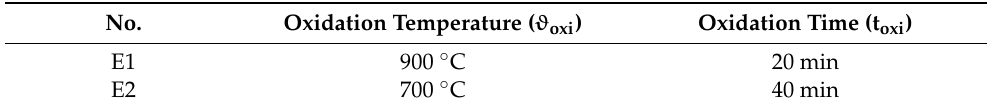
Table 1. Parameters for the oxidation